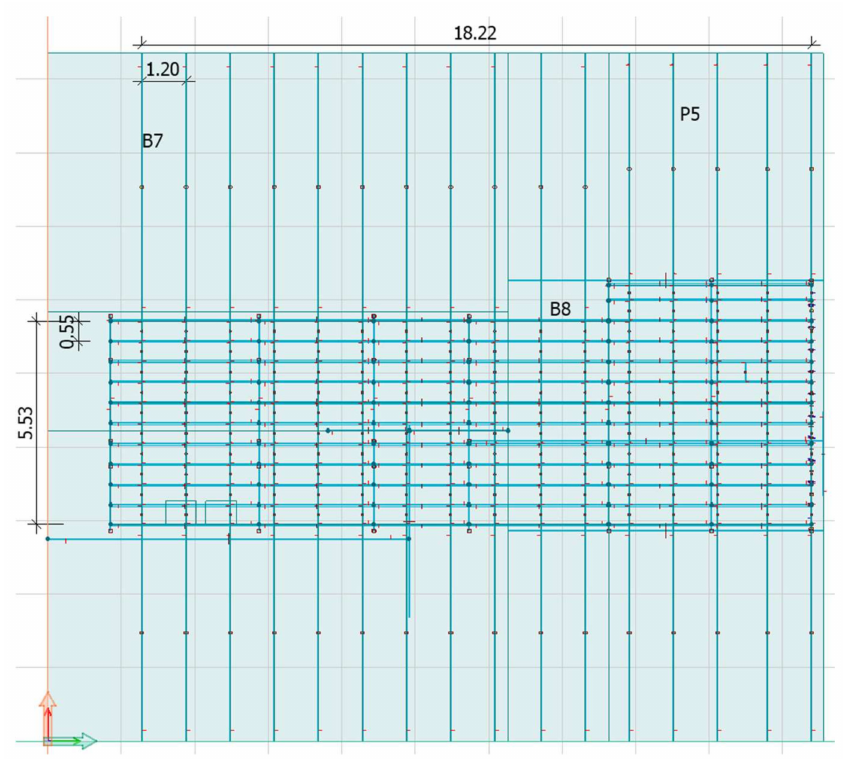
Figure 10. Roof plan with named load-bearing elements (unit: